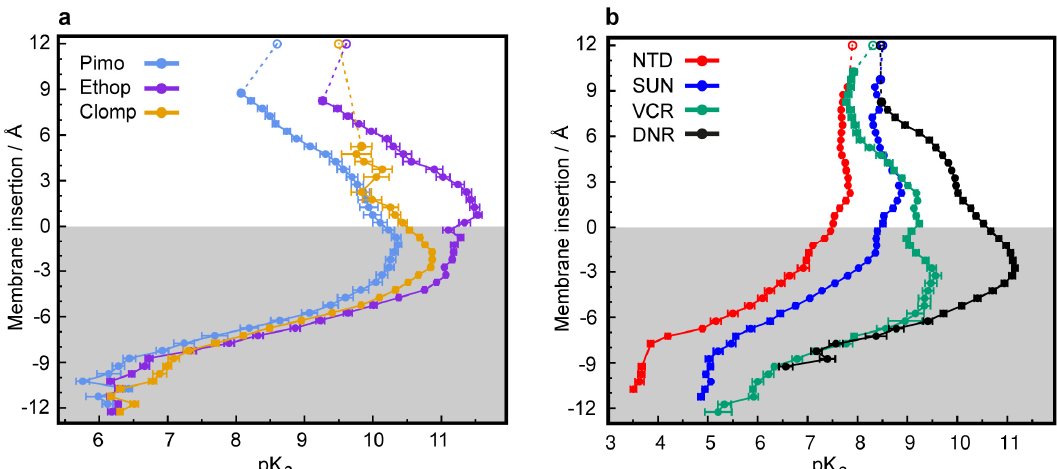
Figure 6. Predicted shifts in p K a values during membrane insertion. p K a profiles along the membrane normal for the CNSDs ( a ) and anticancer drugs ( b ). The unfilled points represent the experimental solution p K a values (Figure S1). The gray-shaded areas represent the membrane internal regions below the phosphate atoms, which are used as insertion references (see Materials and Methods).